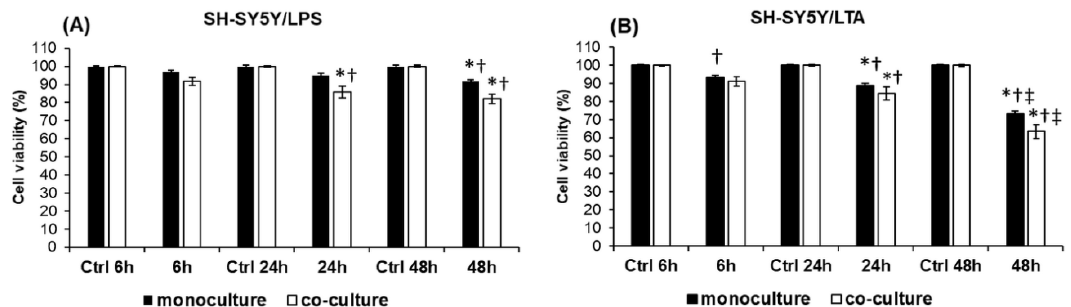
Figure 1. Viability of mono- and co-cultured SH-SY5Y cells after LPS and LTA treatments. Cell viability was determined using Cell Counting Kit-8 (Sigma-Aldrich Kft., Budapest, Hungary) and was expressed as percentage of the control cells. ( A ) Viability of LPS treated SH-SY5Y cells and co-cultured SH-SY5Y cells. ( B ) Viability of LTA treated SH-SY5Y cells and co-cultured SH-SY5Y cells. The columns represent mean values and error bars represent standard errors of the mean (SEM) of four independent determinations. Asterisk stands for p < 0.01 between mono- and co-cultures. Double cross means p < 0.01 between LPS and LTA treatments. Cross shows p < 0.01 compared to the untreated controls.